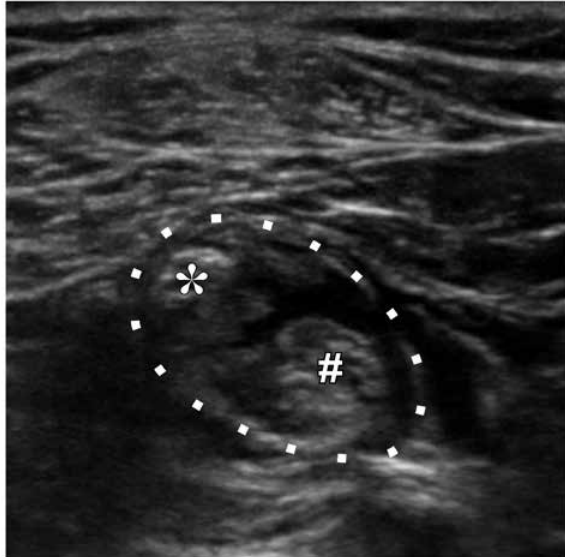
Figure 1: Post-block sonogram of the sciatic nerve. Sonogram of the SN just proximal to its bifurcation after subparan- eural injection of local anesthetic. The dotted line marks the paran- eural sheath enveloping the tibial (*) and the common peroneal (#) nerves, which are separated by the injected local